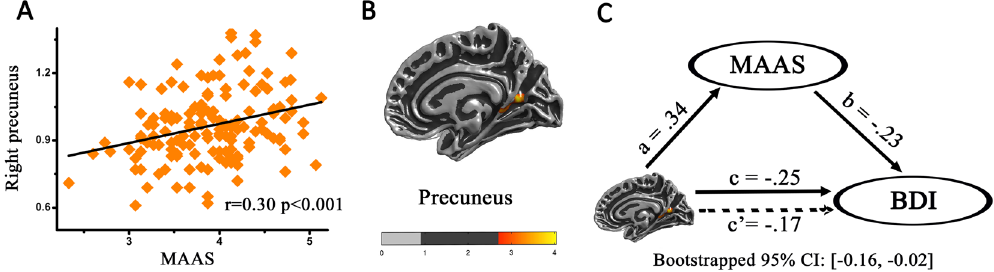
Figure 2. Cortical volume correlated with MAAS scores. ( A ) The scatter plot shows the pattern of correlation between MAAS scores and the right precuneus. ( B ) The right precuneus exhibited a significant positive correlation with MAAS scores. ( C ) Mediation analysis: Path c is the total effect of the depression symptoms on the precuneus; path c’ is the direct effect of the depression symptoms on the precuneus; after controlling for MAAS scores, the product of the paths a and b (ab) is the indirect effect of the depression symptoms through MAAS on the precuneus.